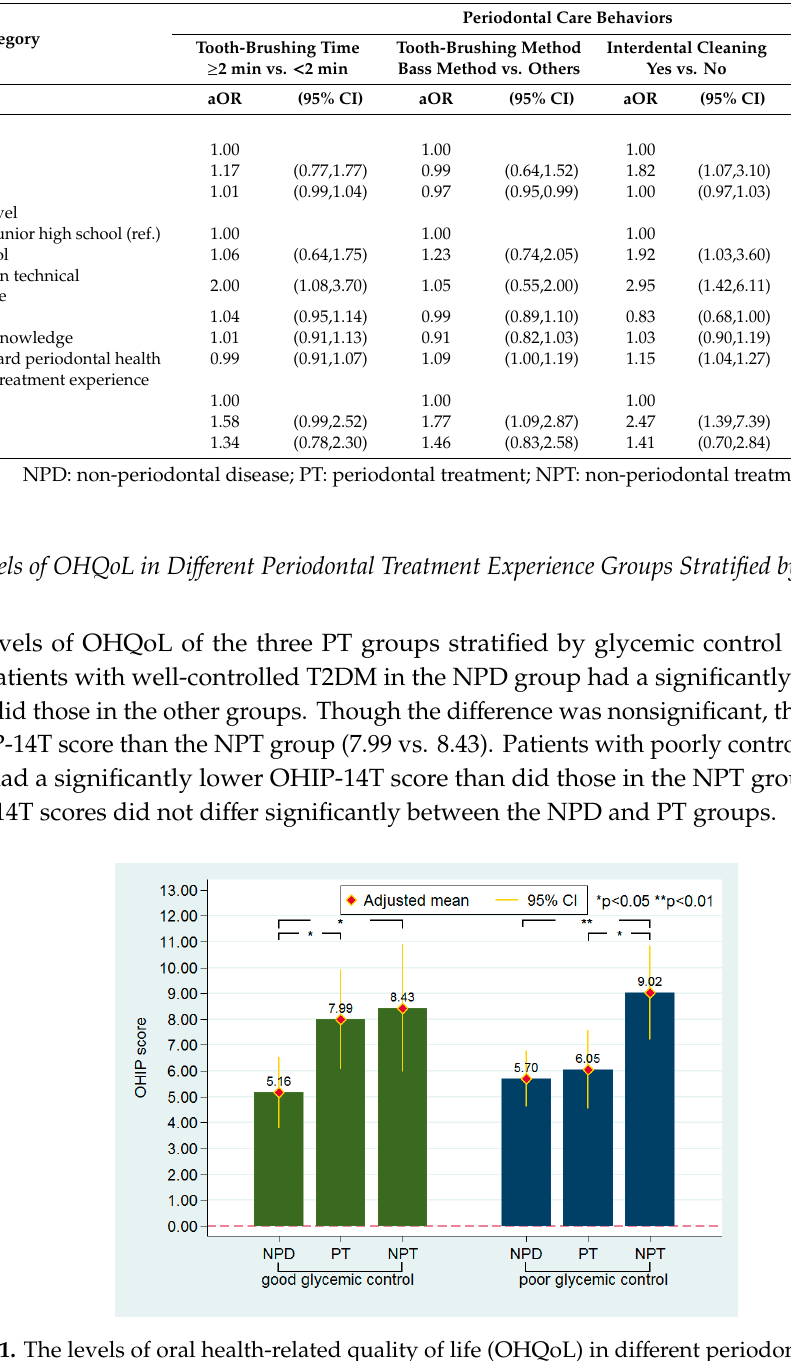
Periodontal Care Behaviors Tooth-Brushing Time Tooth-Brushing Method Interdental Cleaning Routine Dental Visit ≥ 2 min vs. < 2 min Bass Method vs. Others Yes vs. No Yes vs. No aOR (95% CI) aOR (95% CI) aOR (95% CI) aOR (95% CI)